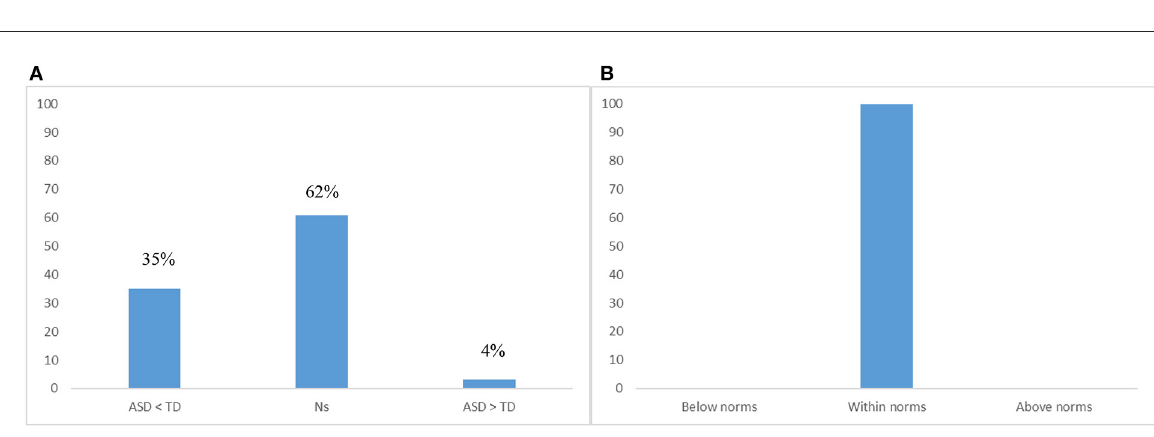
with typical development or participants with diagnosis of ASD with mean age > 12 years old); (criterion 1: wrong population); (b) articles < 10 ASD participants (criterion 2: case series); (c) articles that did not assess word reading